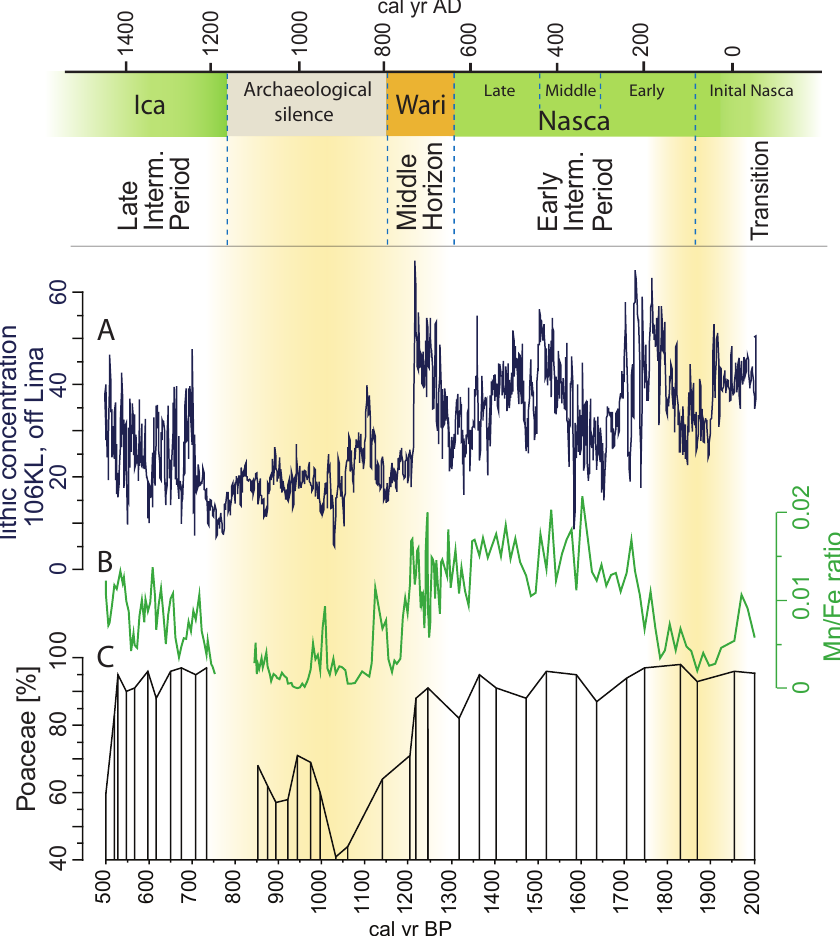
Figure 6. The archaeological chronology of the last 2000 years in the Palpa valleys (Unkel et al., 2012) in comparison to lithic concentration of a marine core from the Peruvian shelf west of Lima ( a ; Rein et al., 2004), Mn/Fe ratios (b) and Poaceae pollen percentages (c) from the Cerro Llamoca